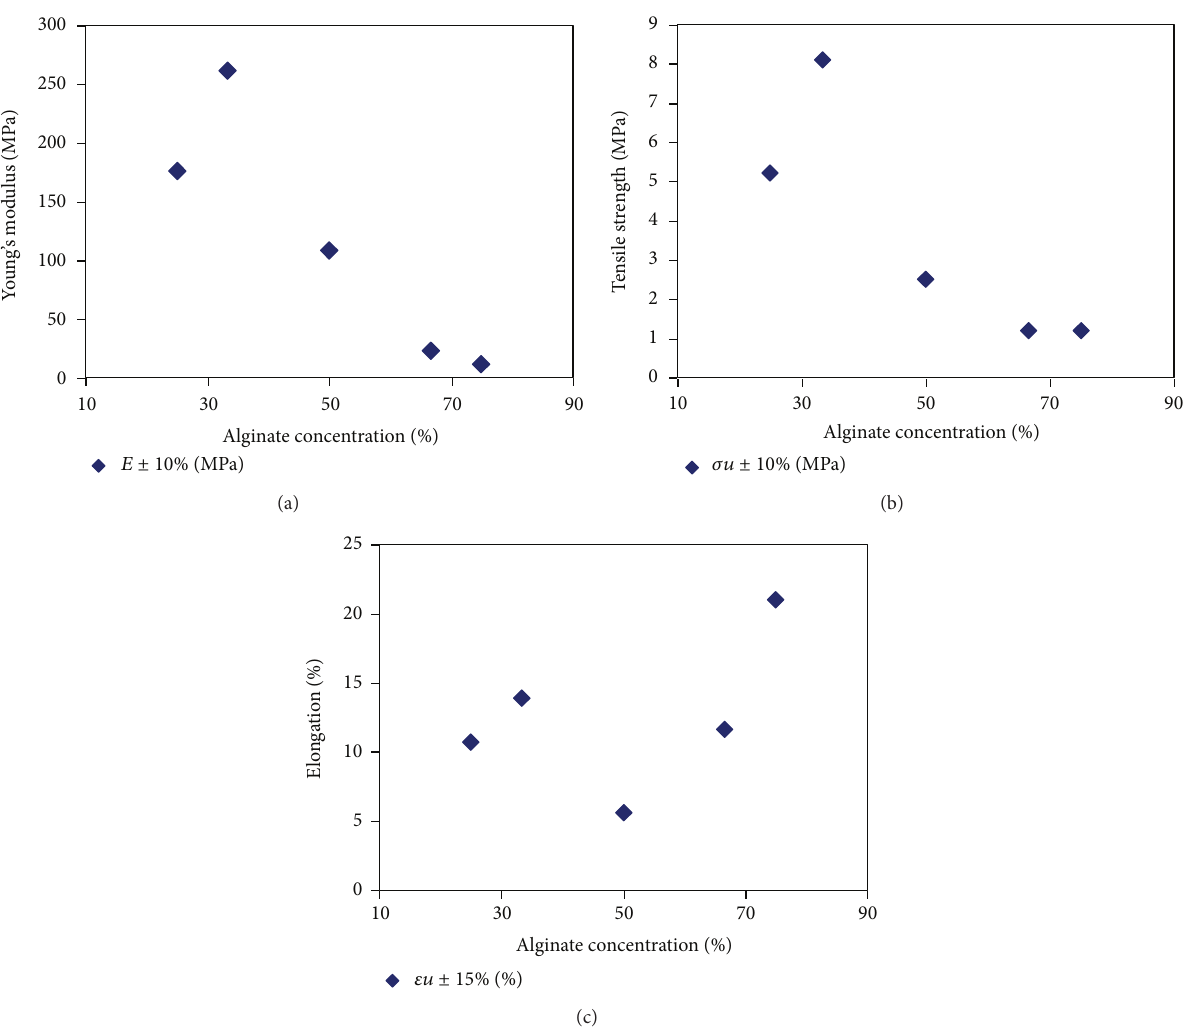
Figure8:Theinfluenceofthealginateconcentrationofhydrogelfilmschemicallycross-linkedonthemechanicalproperties:Young’smodulus (a), tensile strength (b), and elongation at tensile strength (c).